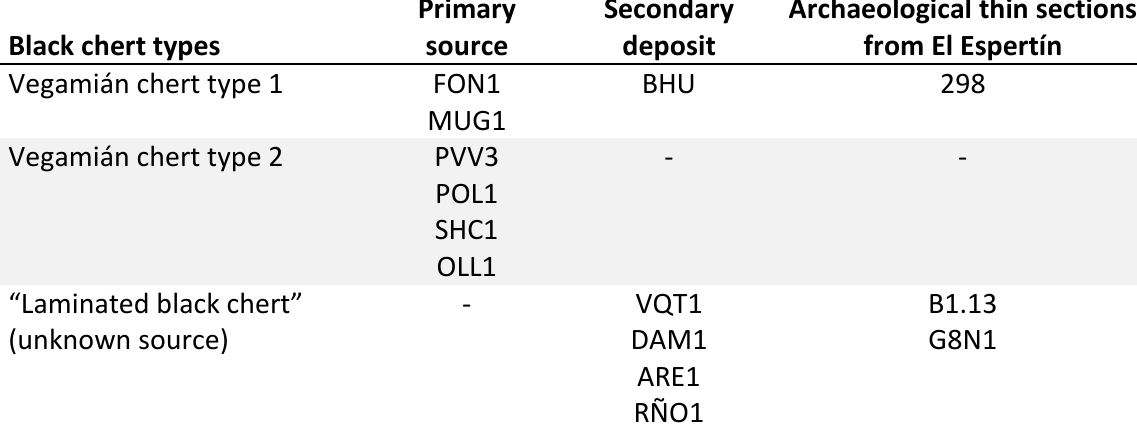
Table 6: Diagram of the black chert varieties and their occurrence in different contexts and from El Espertín cave (Source: Fuertes et al .